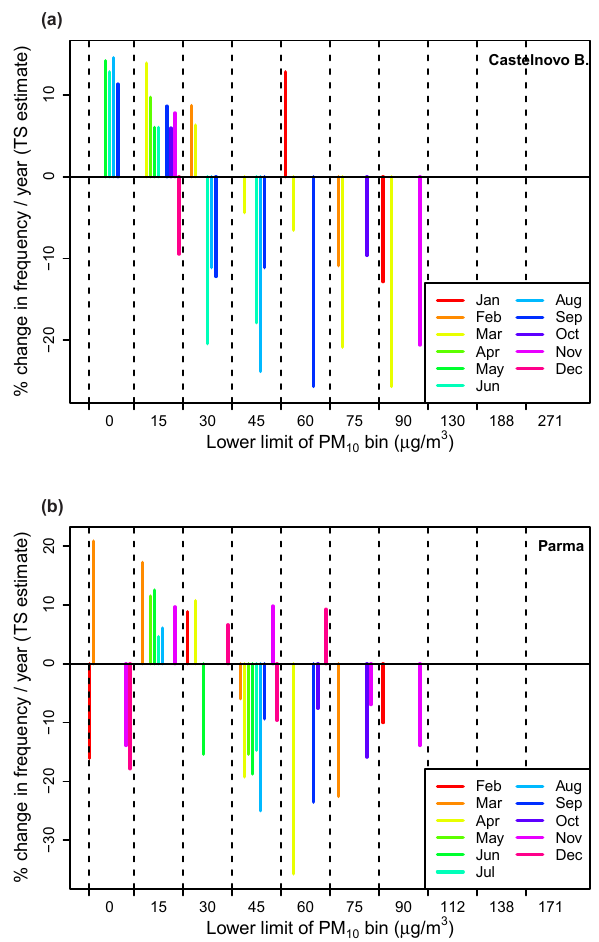
Figure 4. Significant changes in monthly frequency distribution of PM 10 at Castelnovo Bariano (a) and Parma (b) .